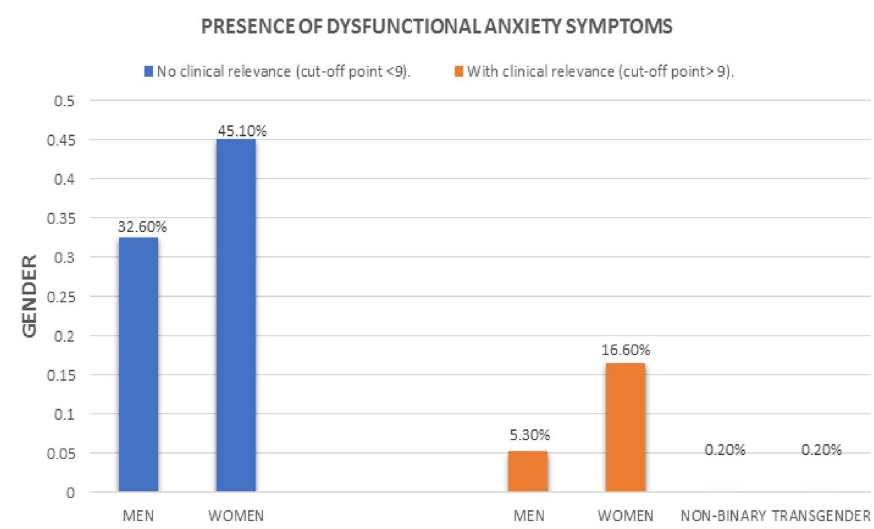
Fig. 2 Presence of dysfunctional anxiety symptoms with and without clinical relevance in the sample